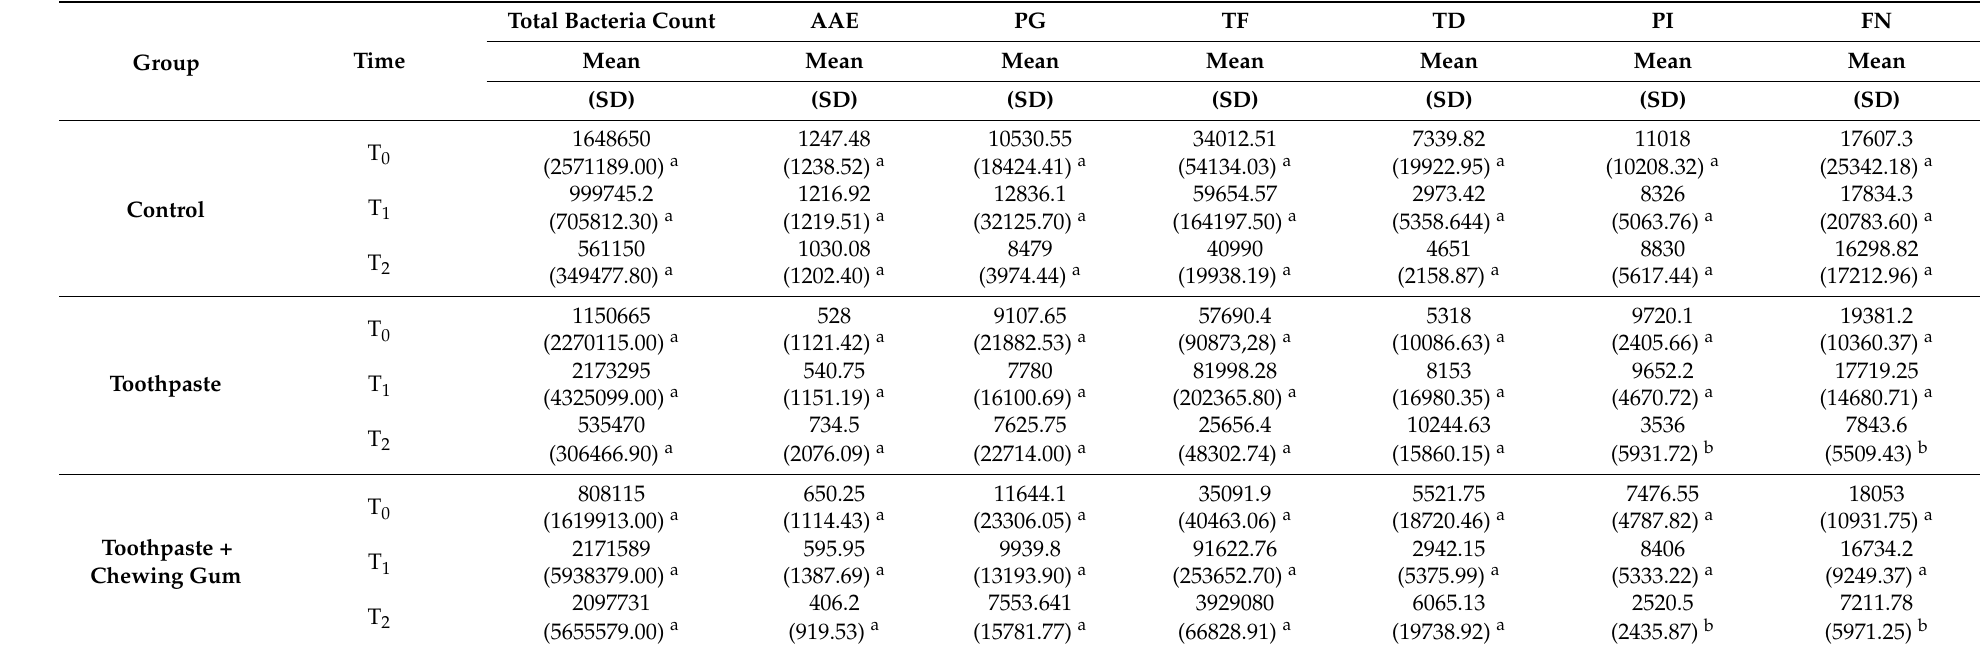
Table 4. Descriptive statistics of microbiological parameters